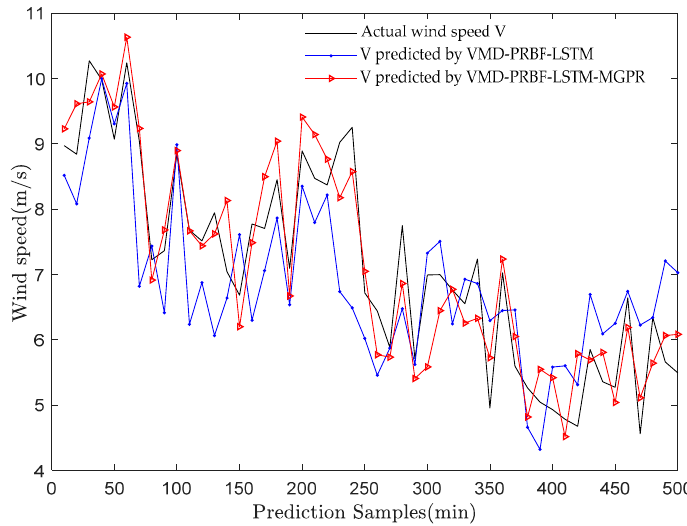
Figure 15. The results of comparison models (EMD-LSTM and EMD-RBF).